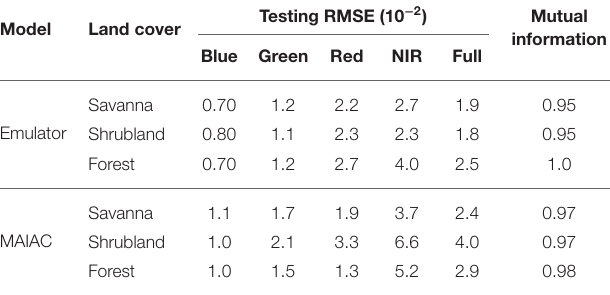
TABLE 2A | Performance metrics by band and for full spectrum for ResNet, ResNet with partial convolutions (Resnet-P), CNN, CNN with partial convolutions (CNN-P), and MAIAC.